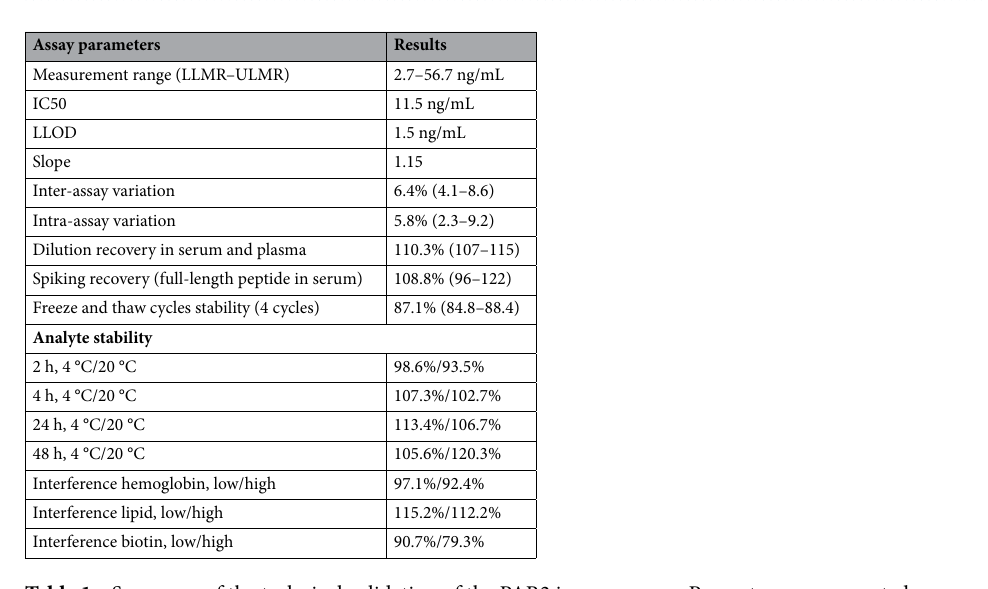
Table 1. Summary of the technical validation of the PAR2 immunoassay. Percentages are reported as means (range). LLMR: lower limit of measurement range, ULMR: upper limit of measurement range, IC50: half maximum of inhibitory concentration, LLOD: lower limit of